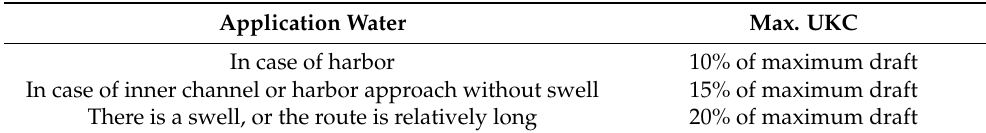
Table 1. The Korean Ministry of Ocean and Fisheries (MOF) “Port and Harbor Design Standards” relating to a ship’s under-keel clearance (UKC).